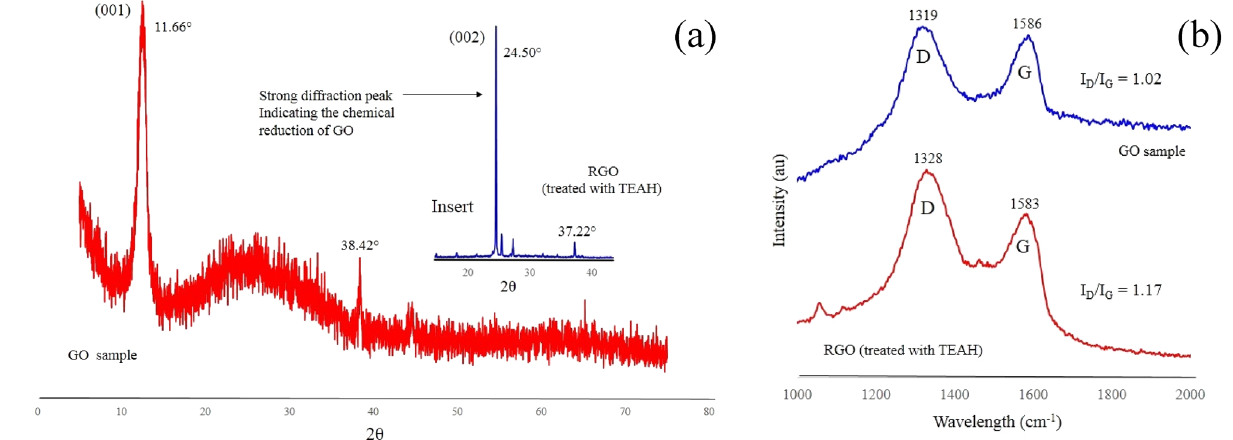
Figure 3. ( a ) XRD patterns and ( b ) Raman spectra of GO and RGO